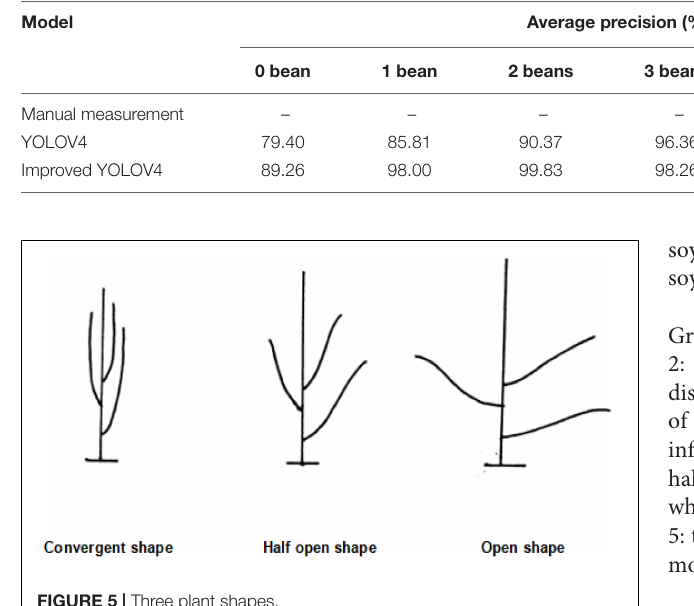
FIGURE 5 | Three plant